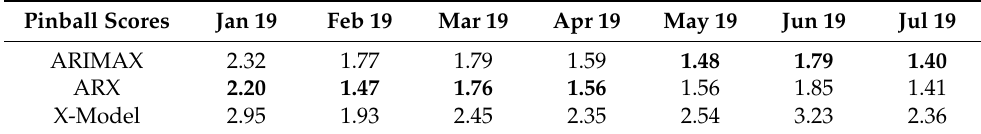
Table 4. Monthly average pinball score for each method. In bold is the best-scoring method for each month. Pinball Scores Jan 19